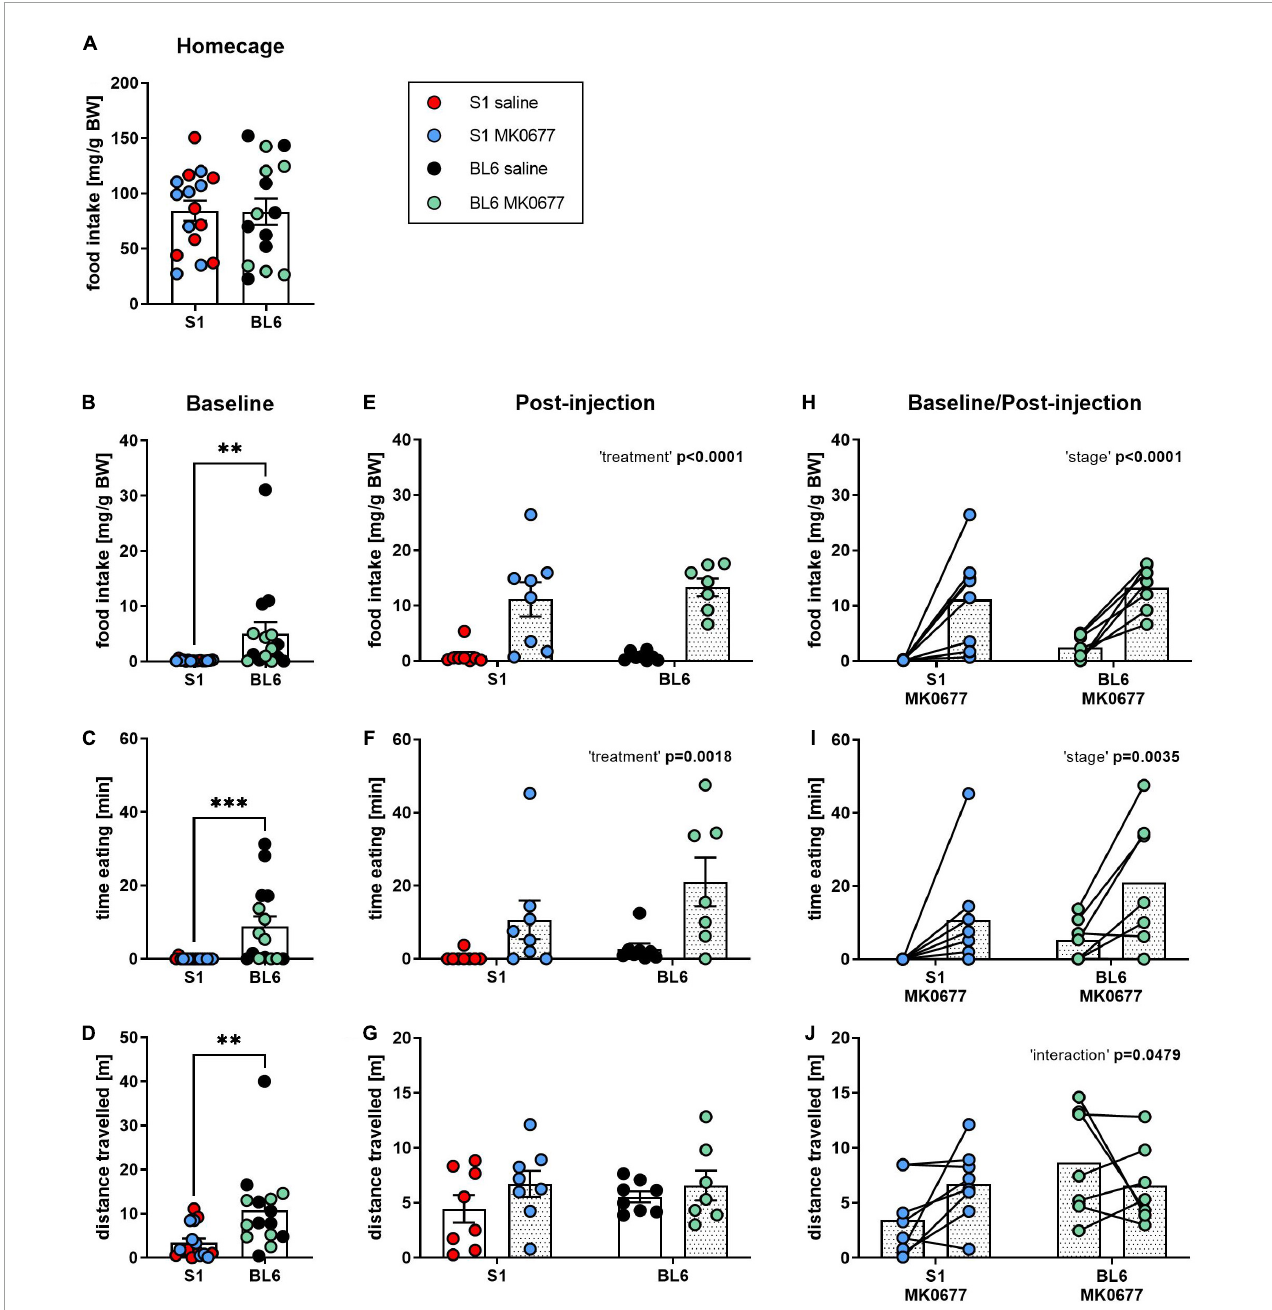
FIGURE1 Eating response to a single injection of ghrelin receptor (GHSR) agonist MK0677 intraperitoneally (i.p., 10 mg/kg) in 129S1/SvImJ (S1) and C567BL/6J (BL6) mice. (A) Overnight (16 h) home cage food intake. Overnight food intake did not differ between the strains ( p = 0.9580). (B–D) Baseline (90 min) food intake, time spent eating and distance traveled. At baseline, food intake ( ∗∗ p = 0.0021), time spent eating ( ∗∗∗ p = 0.0001) and distance traveled ( ∗∗ p = 0.0023) were significantly higher in BL6 than S1 mice (E–G) . Post-injection (90 min) food intake, time spent eating and distance traveled. Mice